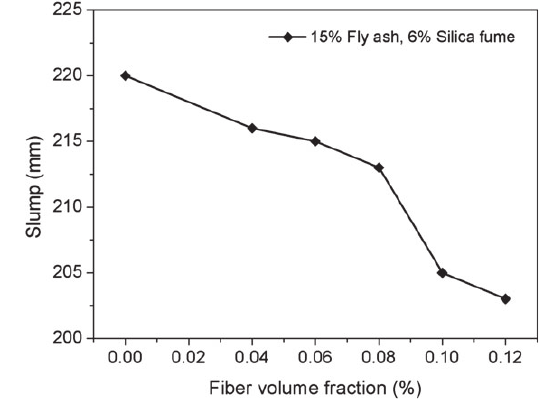
Figure 3 Effect of the polypropylene fiber on the